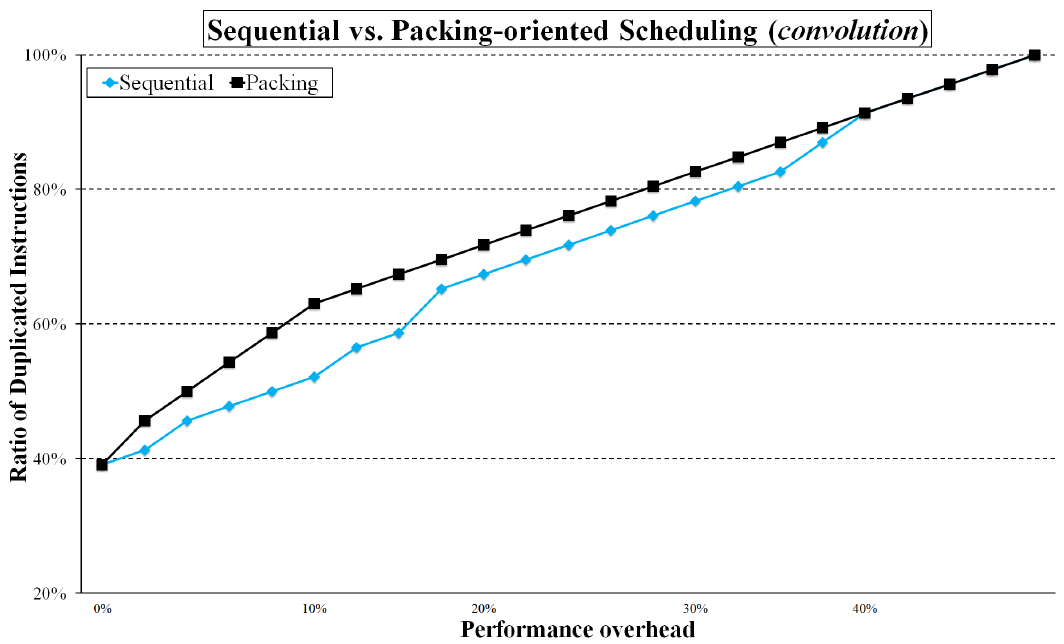
Figure 5. Our packing-oriented duplication can duplicate 18% more instructions as compared to previous sequen- tial